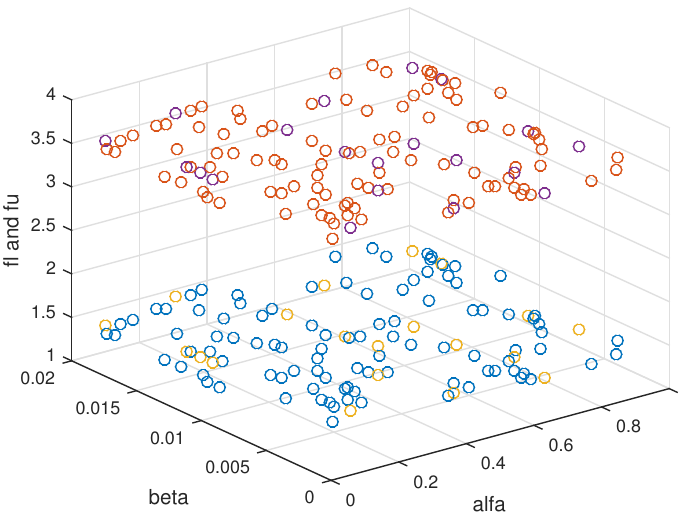
Figure 2. Efficient space for Example 3 with SOC constraint using n =